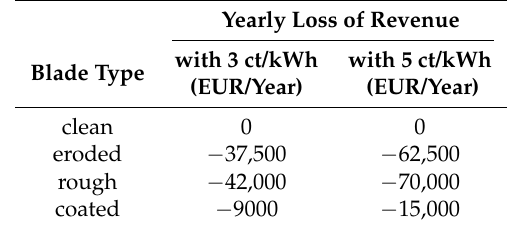
Table 7. Comparison of the yearly loss of revenue using different blades for two exemplary energy prices (losses are compared to the yearly revenue of the clean turbine blades). Yearly Loss of Revenue with 3 ct/kWh with 5 ct/kWh Blade Type (EUR/Year) (EUR/Year) clean 0 0 eroded − 37,500 − 62,500 rough − 42,000 − 70,000 coated − 9000 −